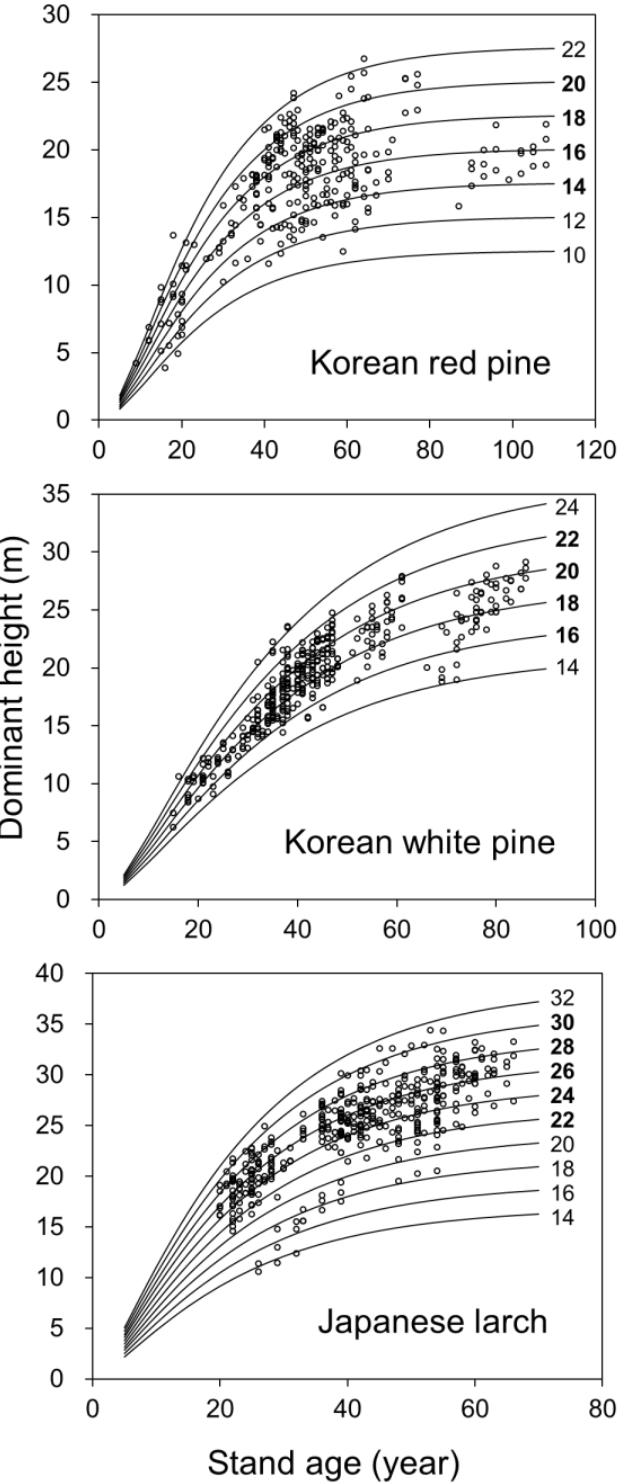
Figure 3. Site index curves based on the Chapman–Richards function with observations by species. The model curves by species were computed using Equation (8) with the fixed-effect parameters in Table 3. The site index indicates the dominant height at a base age of 40 years for all three species. The range of bold values by species represents the majority of the site index distribution in our